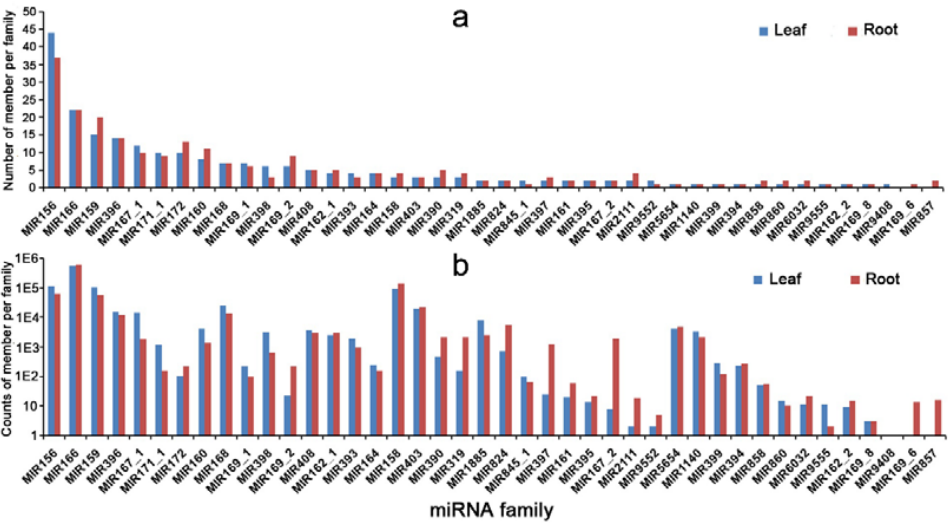
Figure 5. Sizes and abundance of identified known miRNA families from leaves and root of Brassica juncea : ( a ) Distribution of known miRNA family size in Brassica juncea ; ( b ) Log2 (counts) of each known miRNA family from leaves and roots of Brassica juncea .